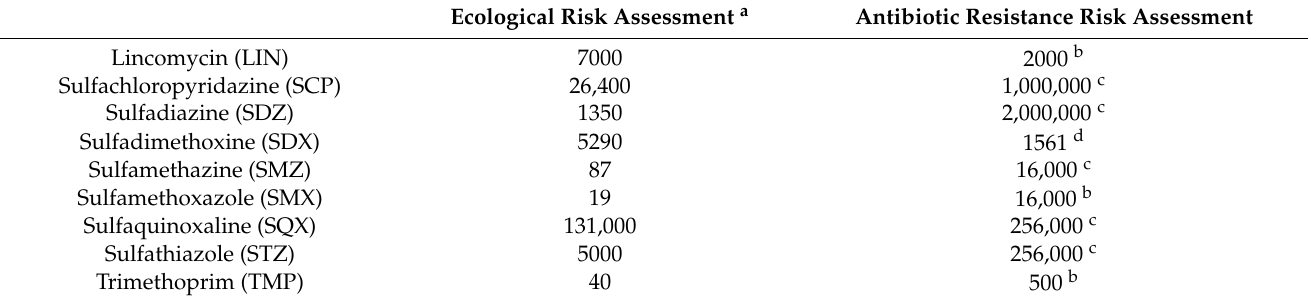
Table 1. Predicted no effective concentrations (PNECs) of the studied antibiotics.